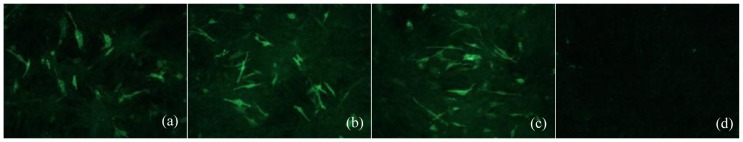
Demonstration of H9N2-NA or NDV-F expressing cells in IFA with monospecific sera in CEF transfected with different plasmids or their combinations (×200).(a) IFA with mouse anti-NA polyclonal serum to NA in CEF co-transfected with pPpp38-NA and pBud-pp38-pp24; (b) IFA with chicken polyclonal anti-F serum to F in CEF co-transfected with pP1.8kb-F and pBud-pp38-pp24; (c) IFA with mouse anti-NA polyclonal serum and chicken polyclonal anti-F serum to NA and F in CEF co-transfected with pPpp38-NA/1.8kb-F and pBud-pp38-pp24; (d) Detection of NA and F in CEF transfected with pPpp38-NA/1.8kb-F only.